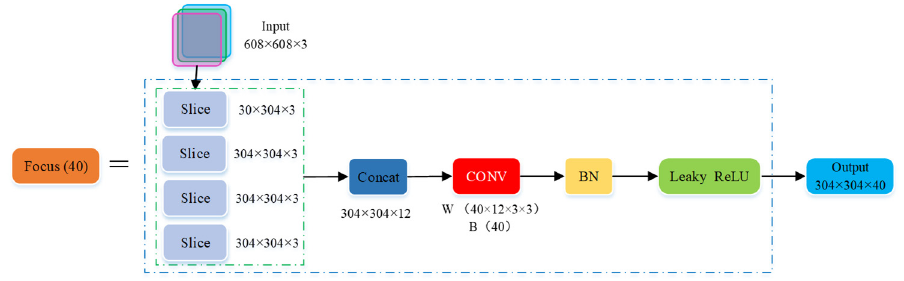
Figure 9. Structure of Focus module .